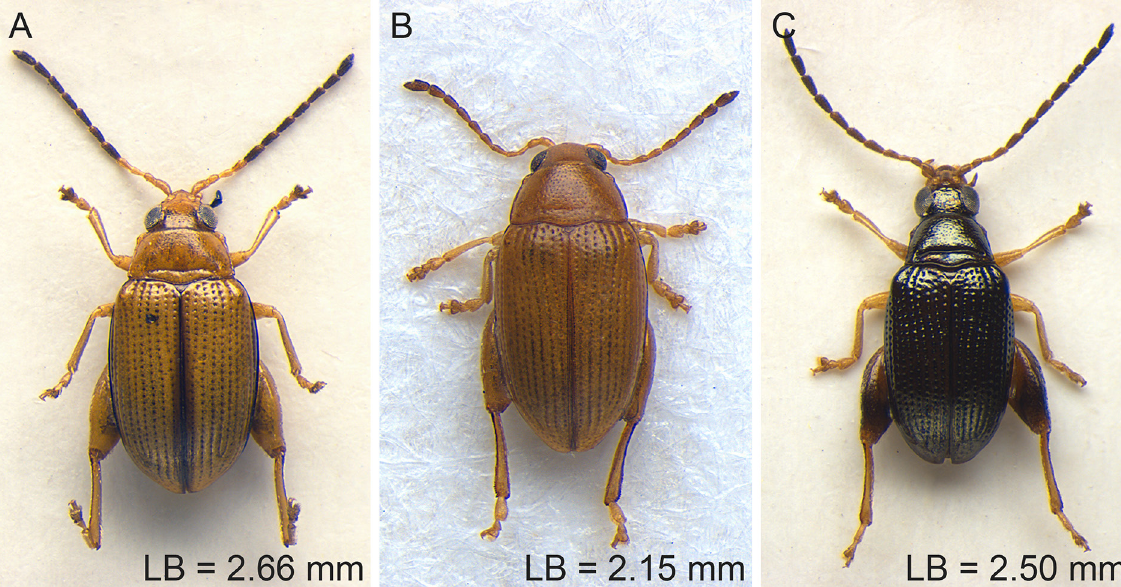
Fig. 3. Habitus. A . Arsipoda wanati sp. nov, Mt Humboldt. B . A. yiambiae Samuelson, 1973,